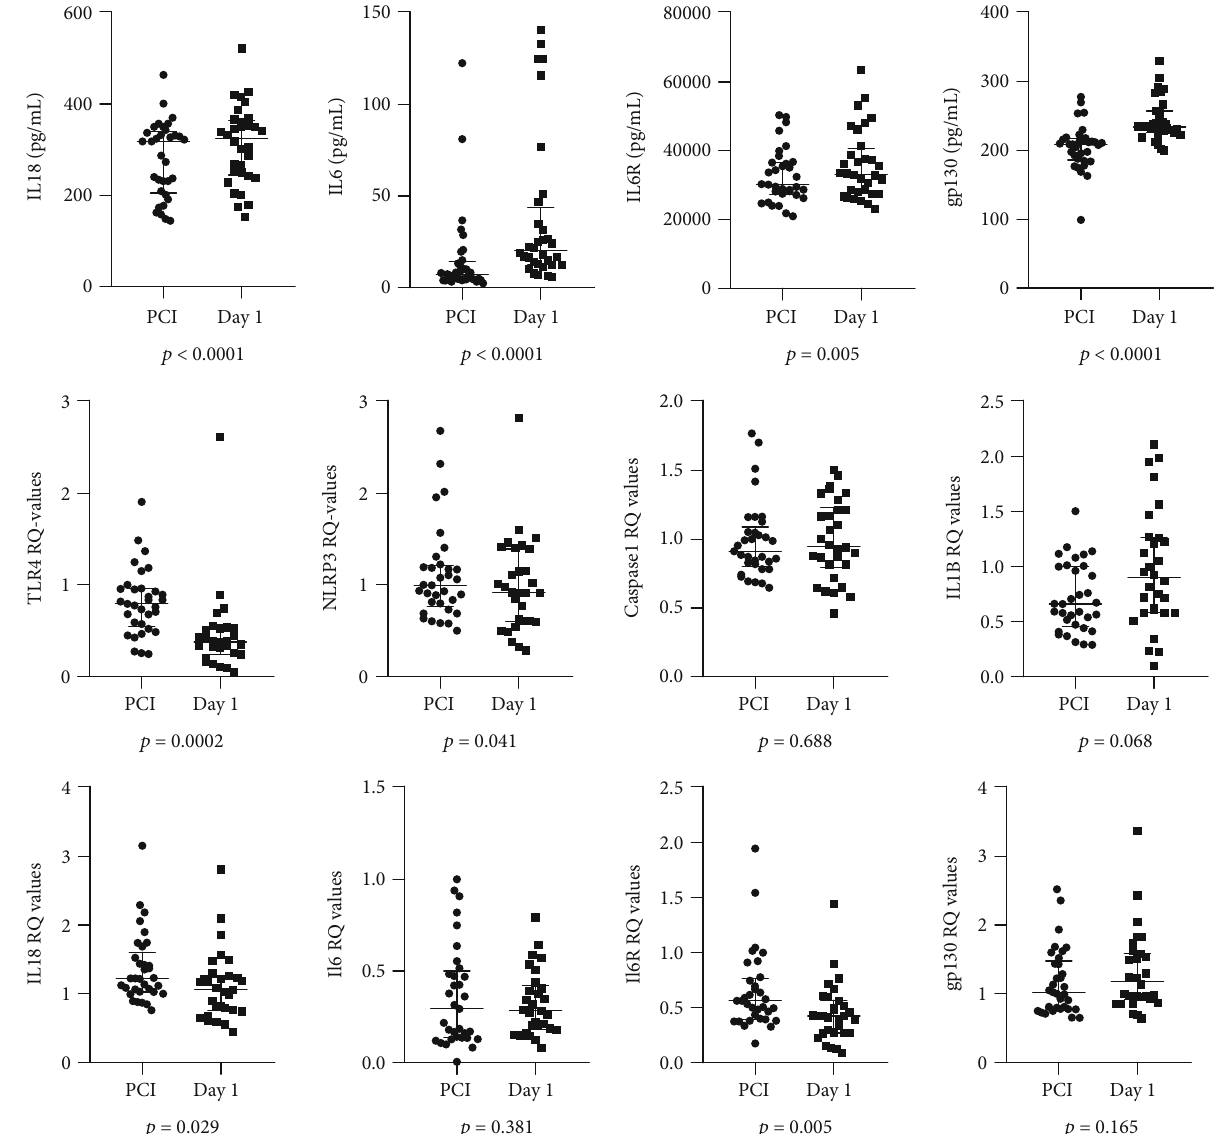
Figure 3: Time of PCI vs. day 1. The fi rst row of graphs shows changes from time of PCI to day 1 in circulating markers ( n = 32 ). The second and third row show changes in genes expressed in circulating leukocytes ( n = 30 for NLRP3, Caspase 1, IL-1 β , IL-18, IL-6R, and gp130. n = 29 for IL-6. n = 28 for TLR4) (Wilcoxon rank-sum test). Dots represent individual data. Horizontal lines are drawn at medians, and 25 th and 75 th percentiles. Abbreviations: TLR4: Toll-like receptor 4; NLRP3: Nod-like receptor protein 3; IL-1 β : Interleukin 1 β ; IL-18: Interleukin 18; IL-6: Interleukin 6; IL-6R: Interleukin 6 receptor; Gp130: Glycoprotein